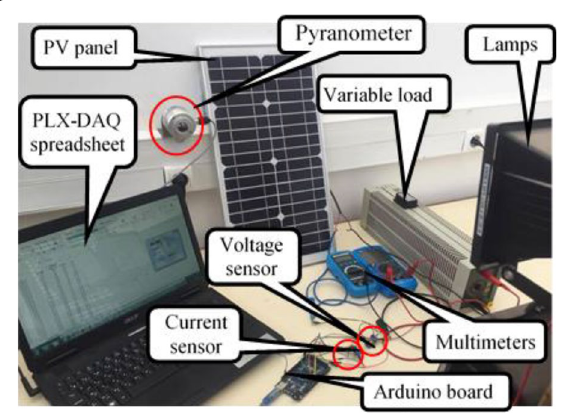
Fig. 12 PLX-DAQ Spreadsheet window Fig. 13 Experimental setup of the virtual instrumentation